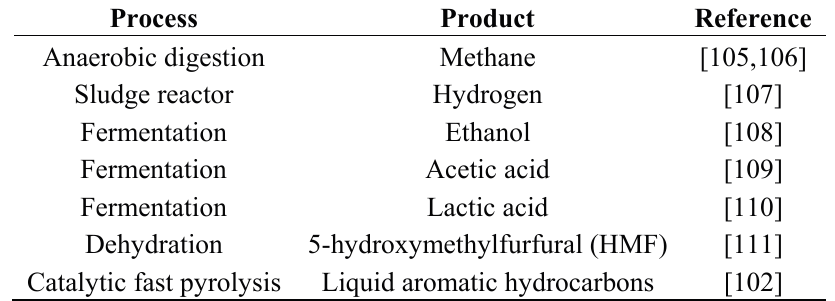
Table 1. Recent process aimed at converting mixed food waste into chemical